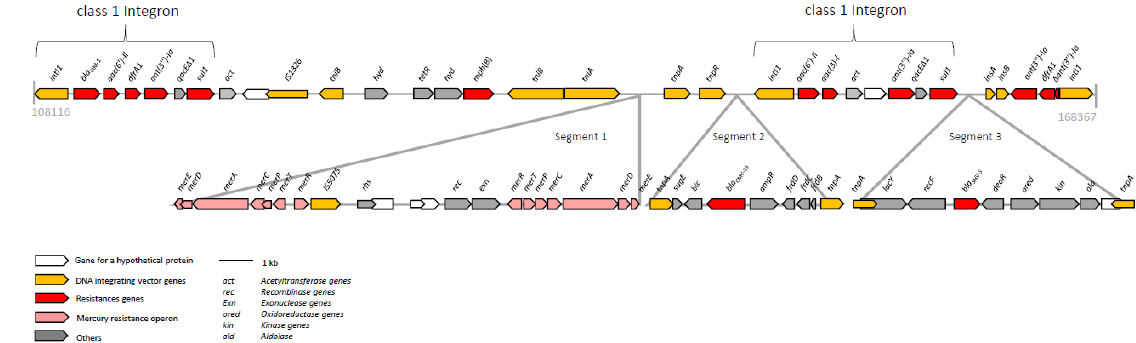
Figure 1. Schematic illustration of the multidrug-resistance region of plasmid pEC19-AB01133. The reading frames are displayed as arrows with the arrowhead showing the direction of transcription. The numbers refer to the whole plasmid sequence of pEC19-AB01133, which is deposited in the GenBank database under accession no. MT682138.